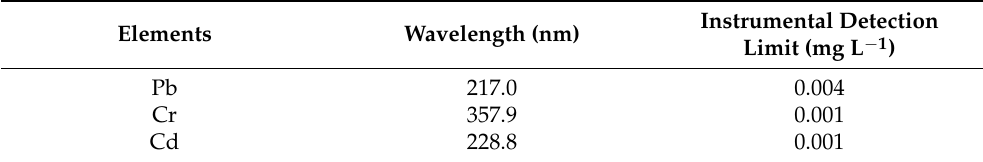
Table 2. Spectral lines used in emission measurements and the instrumental detection limit for the elements tested by using